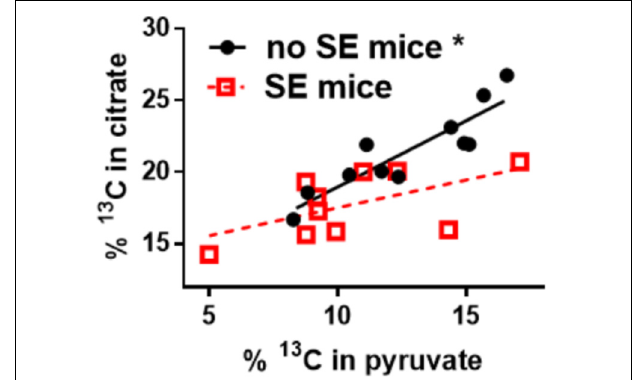
FIGURE 2 | Alteration of 13 C-pyruvate entry into the TCA cycle in hippocampal tissue of chronically epileptic mice. 13 C-glucose was injected (i.p.) into mice that were in the chronic epileptic stage of the pilocarpine SE model (SE mice - red open squares) and control no SE mice, which do not show spontaneous seizures (black circles). 15 min later mice were sacrificed and the hippocampi extracted for LCMS-MS analysis. The % enrichment of 13 C-containing citrate was plotted against the % enrichment of 13 C-containing pyruvate. A reduction of 13 C-carbon entry into the Krebs cycle can be observed in the 17% lower hippocampal % 13 C enrichment in citrate in SE vs. no SE mice ( p = 0.004, please note that the pyruvate levels were similar). Also, there is a lack of correlation of % 13 C enrichment in citrate vs. that of pyruvate in SE mice (slope is not significantly different from zero, p = 0.08), while in no SE mice there is a correlation ( p = 0.0002). The lack of correlation indicates that in “epileptic” mice the pyruvate levels do not determine entry into the Krebs cycle, indicating that some other factor is impaired, for example the activity of PDH. Data from (McDonald et al.,